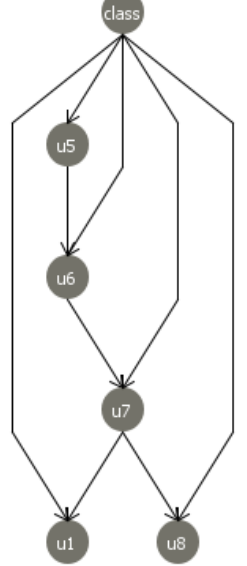
Figure 7. Bayesian network TAN